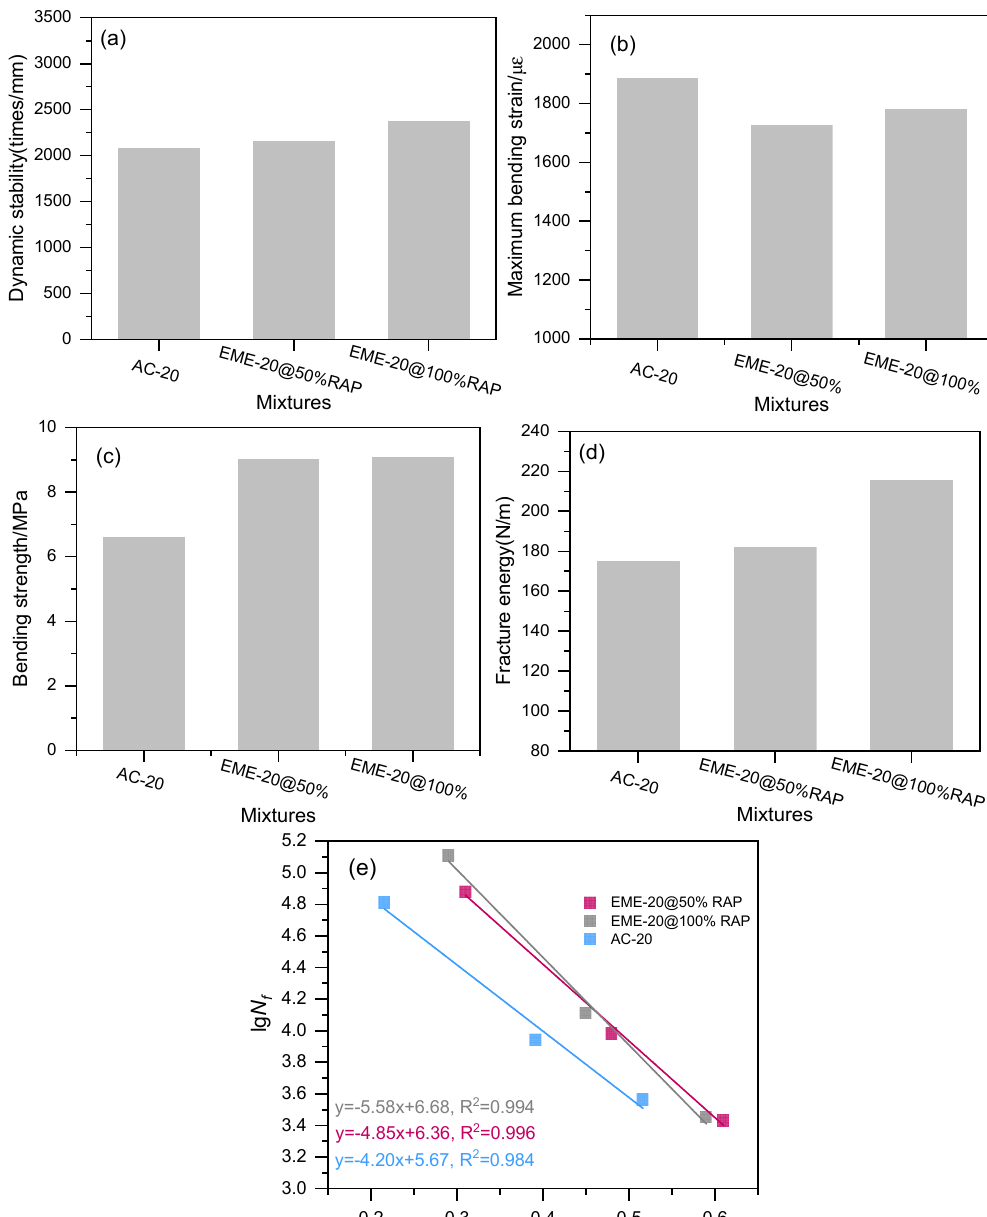
Figure 10. Performance of hot-mix recycled asphalt mixture containing hard asphalt: ( a ) High-temperature rutting resistance; ( b ) Maximum bending strain; ( c ) Bending strength; ( d ) Fracture energy; ( e ) Fatigue performance.